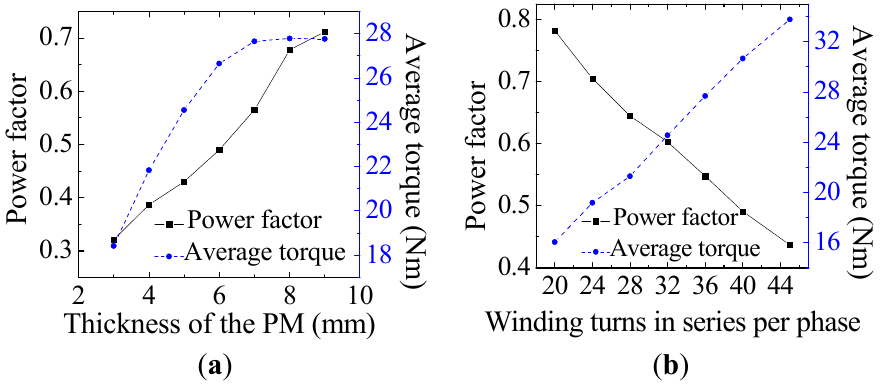
Figure 7. The parametric influences on power factor and average torque. ( a ) thickness of the PM; ( b ) winding turns in series per